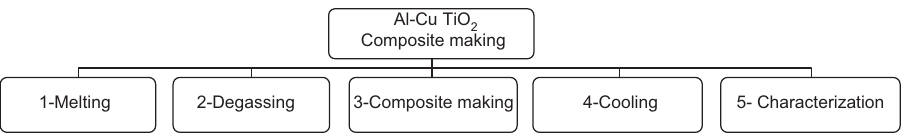
Figure 1 The experimental setup for the ultrasonic treatment of the Al-Cu TiO